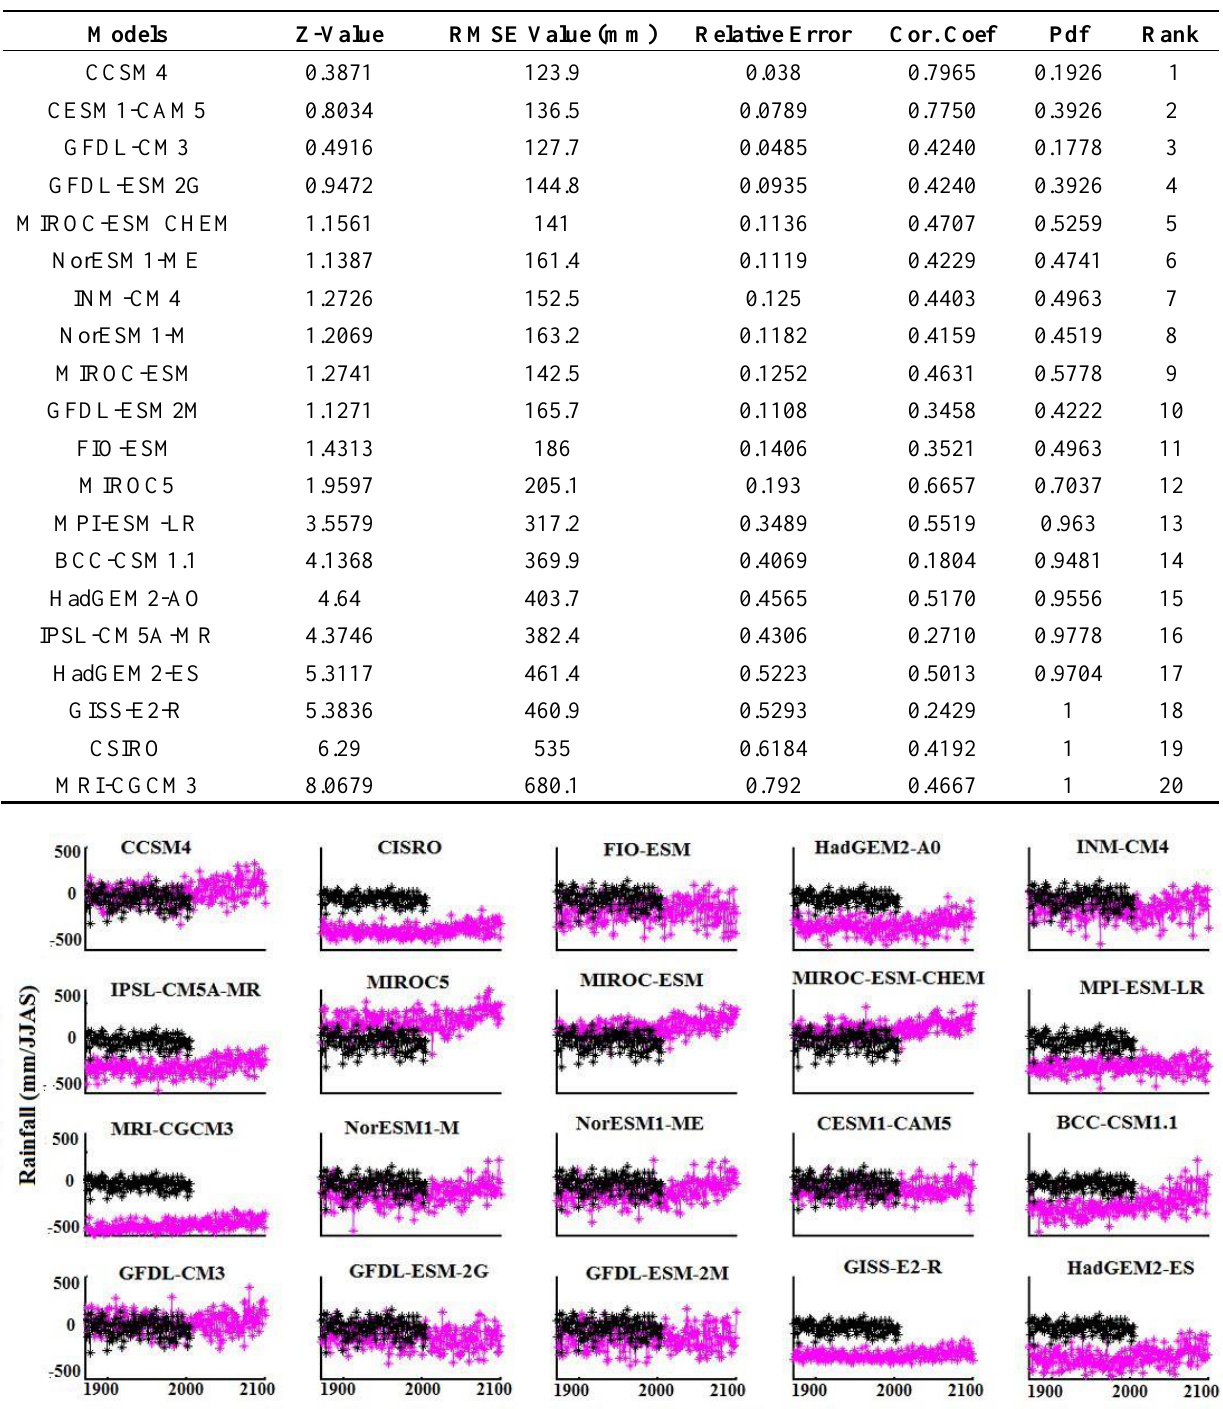
Table 2. Quantitative values of the tests performed.